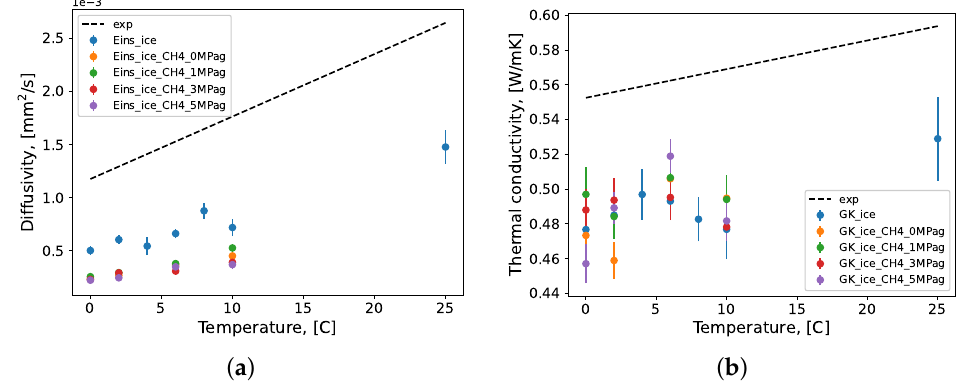
Figure 9. The ( a ) diffusivity and ( b ) thermal conductivity of the methane gas hydrate systems as simulated by MD under pre-nucleation conditions using the TIP4P/Ice water force field model. Repeated simulations produced samples of each condition’s prediction value of size n = 10; these samples were bootstrapped with replacement ( n = 10,000) to calculate mean values, which are presented here with their standard error. GK: Green–Kubo formulation; Eins: Einstein formulation; ice: TIP4P/Ice; exp: linear regression of experimental data for panel ( a ) [99–103]; exp: linear regression of experimental data for panel ( b )